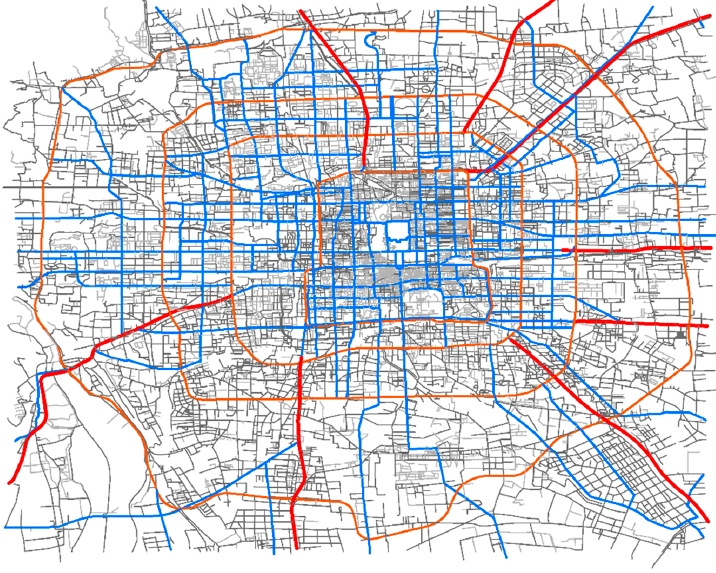
Figure 2. Road network of the city of Beijing.